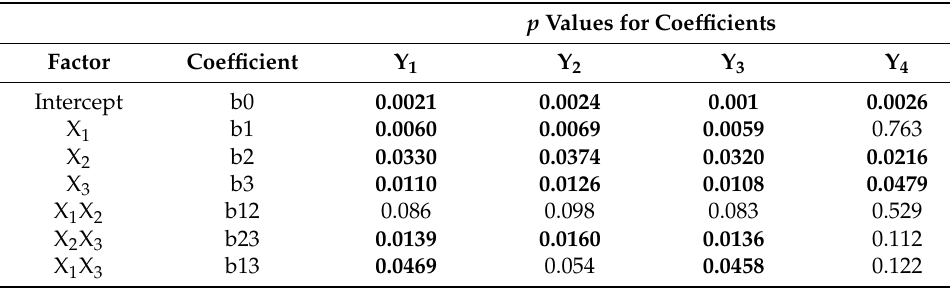
Table 6. Coefficients and their significance for CQAs: Y 1 (particle size), Y 2 (relative deformability), Y 3 (transmittance), and Y 4 (dissolution efficiency). Significant values are in bold type. p Values for